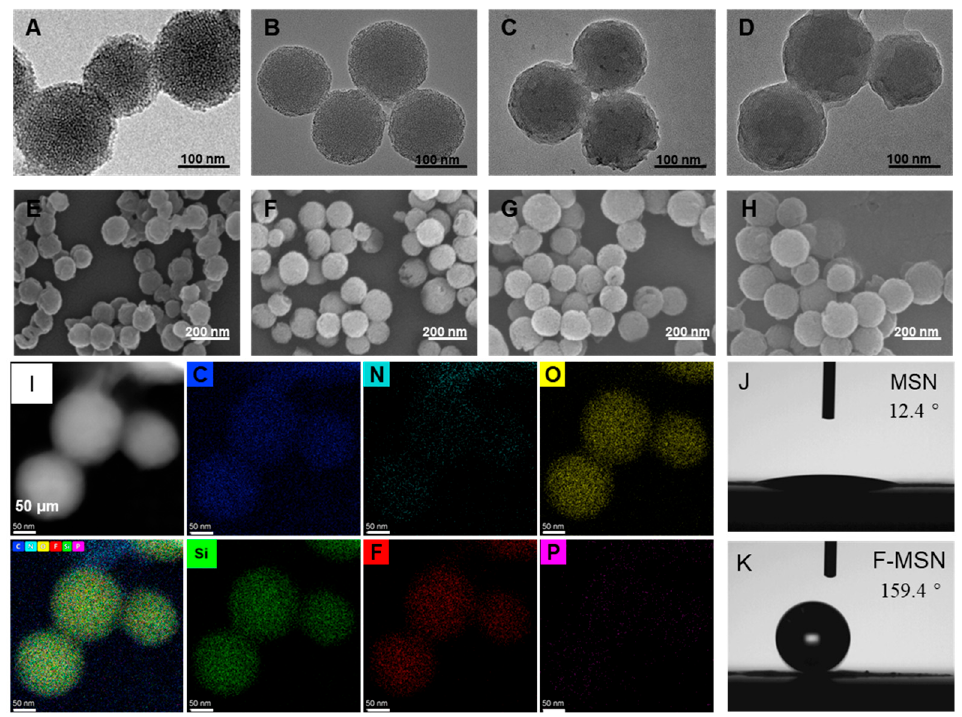
Figure 2. Characterization of NPs. ( A – D ) SEM and ( E – H ) TEM of the MSN, F-MSN, F-MSN-DOX and F-MSN-DOX@RBC; ( I ) SEM image, energy dispersive X-ray (EDX) elemental mapping of C, N, O, SI, F, and P of F-MSN-DOX@RBC; ( J , K ) Contact angle of fi lms made from MSN and F-MSN. Table 1. Size distribution, concentration, and Zeta potentials of NPs.